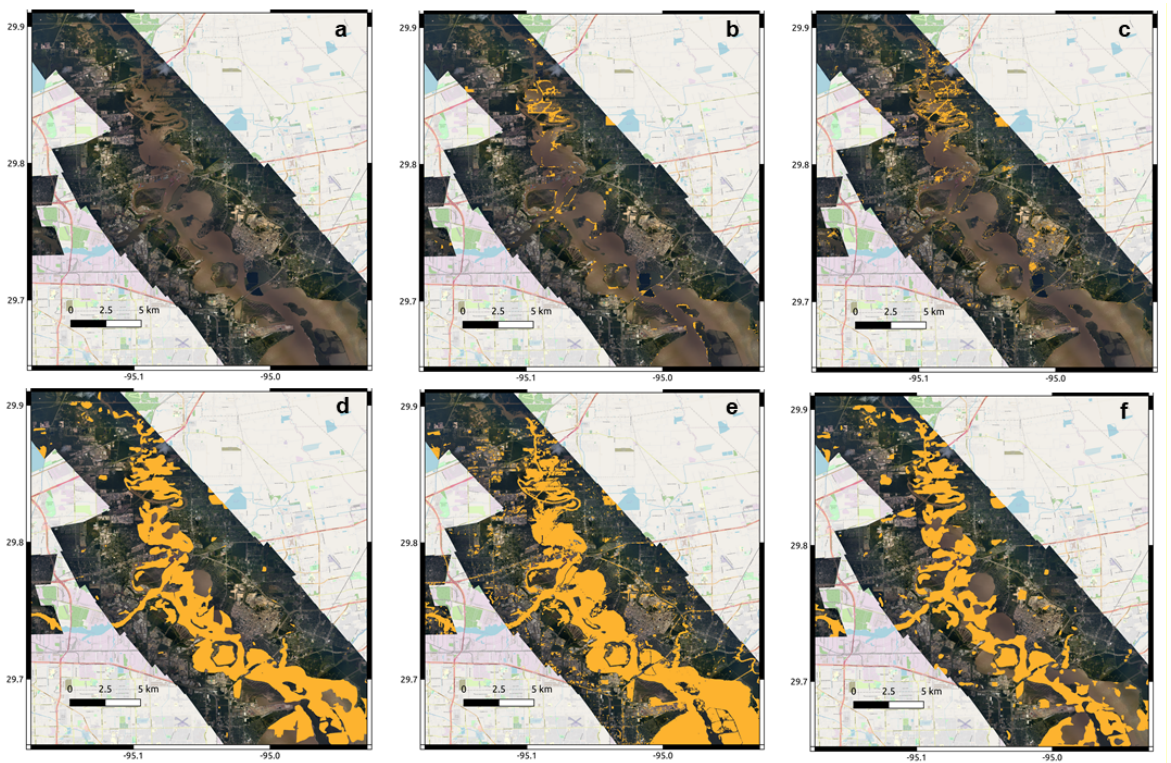
Figure 12. ( a ) NOAA Remote Sensing Division airborne digital optical imagery of the Houston area acquired between 27 August and 3 September 2017, subregion 2, as shown in Figure 2; ( b ) water pixels identified by MODIS data, 250 m pixel spacing, courtesy of the DFO [41]; ( c ) water pixels identified from NDWI analysis of Sentinel-2 data, 10 m pixel spacing; ( d ) water pixels identified by the DeepLabv3+ analysis of SAR GRD data, 29 August 2017, 10 m pixel spacing; ( e ) water pixels identified from thresholding analysis of the same SAR GRD data, 10 m pixel spacing; and ( f ) water pixels identified by the classification analysis of the SAR GRD data, 10 m pixel spacing. The GWM is not removed from the analyses of ( b ) through ( f ). Water pixels are shown in orange.